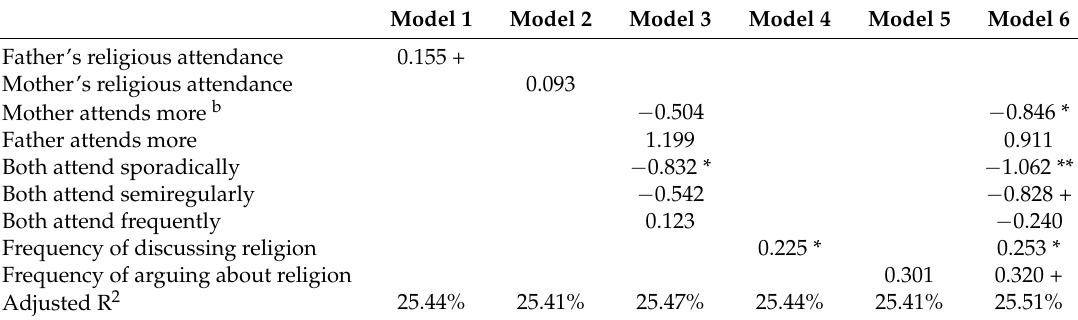
Table 7. Unstandardized coefficients predicting children’s standardized reading test scores (n = 10,720) a